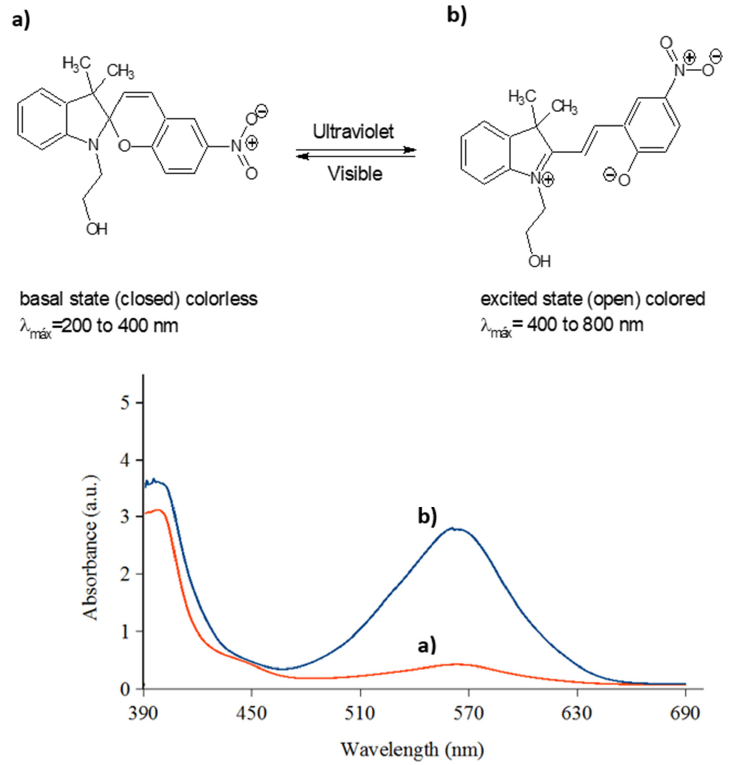
Figure 2. Schematic representation of photo induced reversible interconversion of 1-(2- hydroxyethyl)-3,3-dimethylindoline-6-nitrobenzopyran ( SP ) ( a ) before UV-Vis light irradiation, ( b ) after light